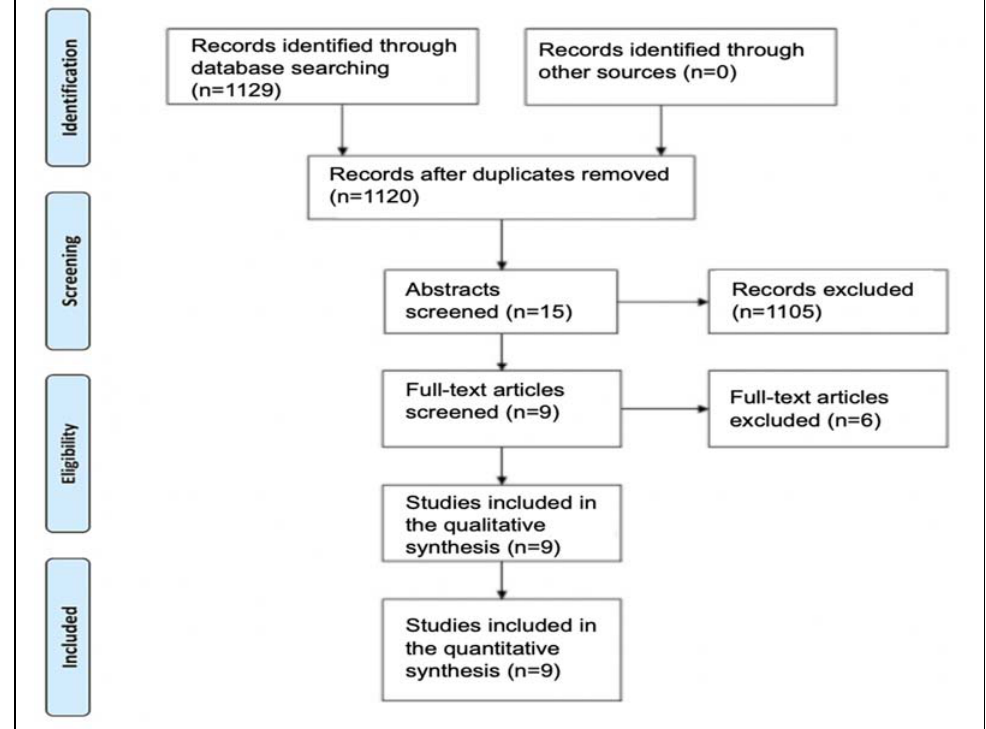
Figure 1. Prisma flow diagram.